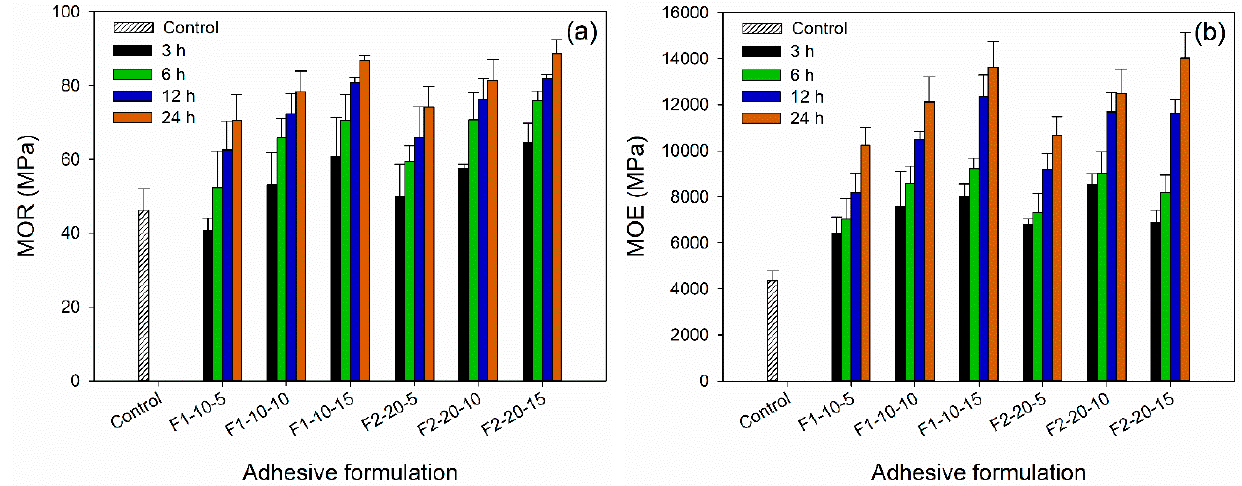
Figure 6. Mechanical properties of plywood bonded with PVOH–tannin–hexamine-based adhesives. ( a ) MOR, ( b ) MOE.